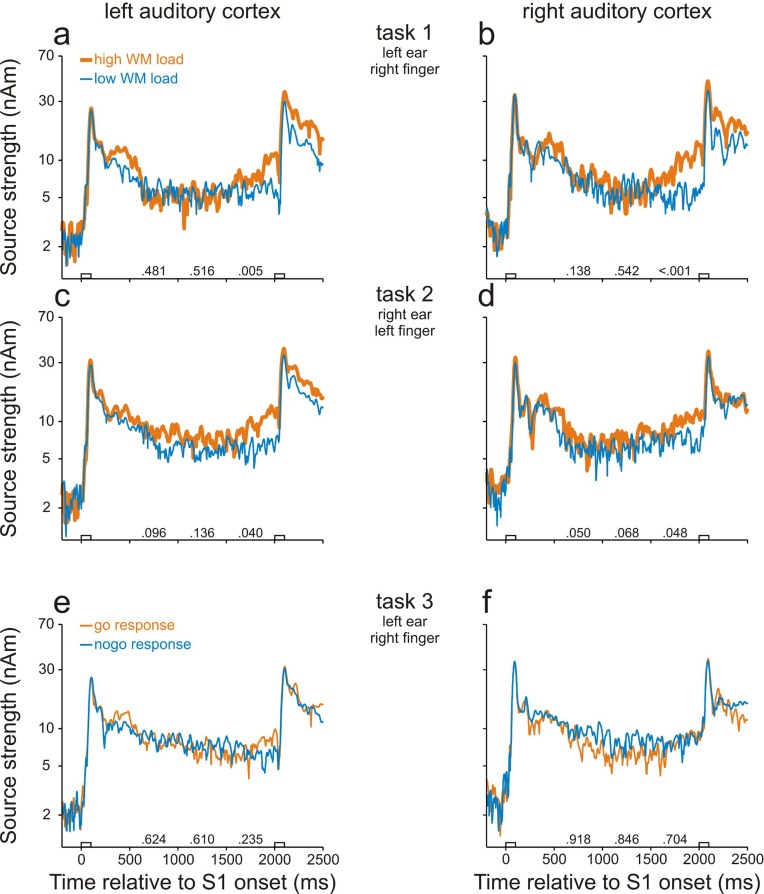
Working-memory related neural activity in human auditory cortex identified in study 1.Strengths of the sources in AC in task 1 (a, b), task 2 (c, d) and task 3 (e, f). Data from the left and right hemisphere are shown in the left and right column, respectively. Each trace represents the grand geometric mean source waveform derived from MEG recordings in 12 subjects. Thick orange and thin blue traces in a–d represent source strengths in high- and low-WM-load trials, respectively. Thin orange and thin blue traces in e–f represent source strengths in go and nogo trials, respectively. The empty bars on the abscissae represent the timing and duration of S1 and S2. The numbers on the abscissae are the p-values of permutation tests for the ratios of the source strength in high- to that in low-WM-load trials or in go to that in nogo trials during the three 500-ms periods of the delay. Note that the ordinates have logarithmic scaling. Also note that the differences in the left and right AC in tasks 1 and 2 reflect differences in WM load.